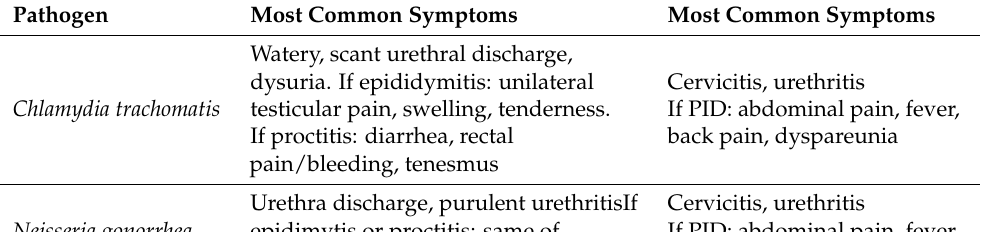
Table 2. Main sexually transmitted infections in LGBTQ+ youths. PID: pelvic inflammatory disease.